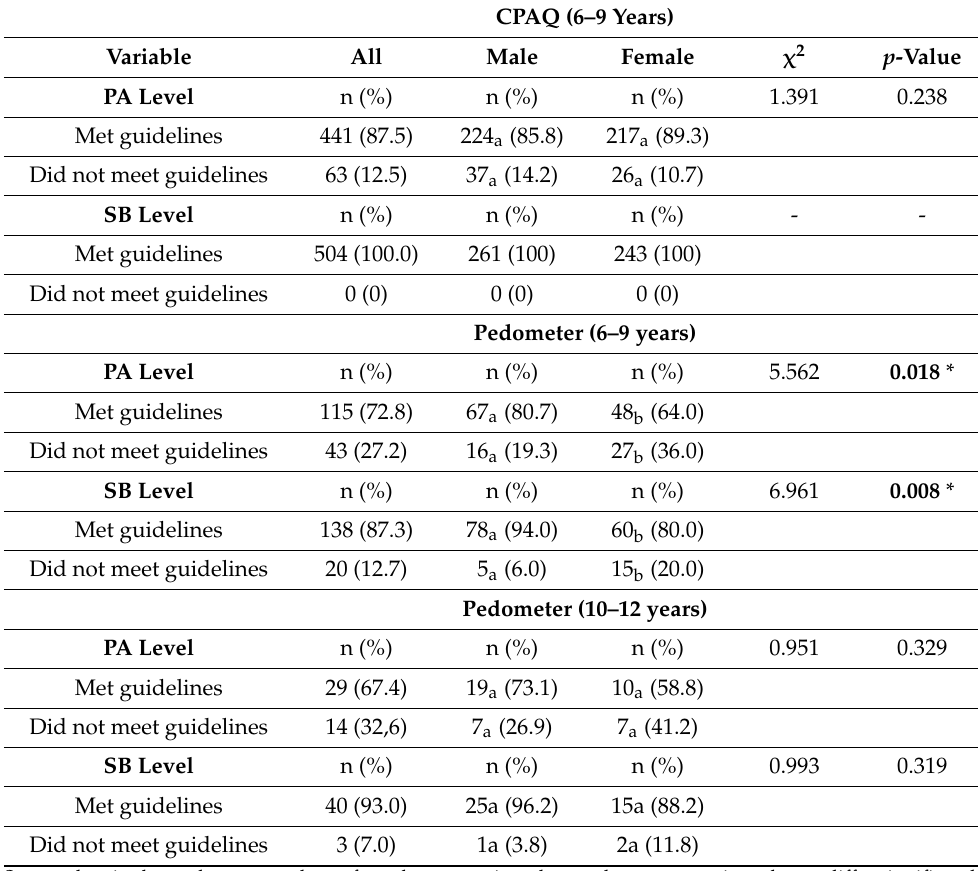
Table 3. Comparison of participants’ levels of physical activity across